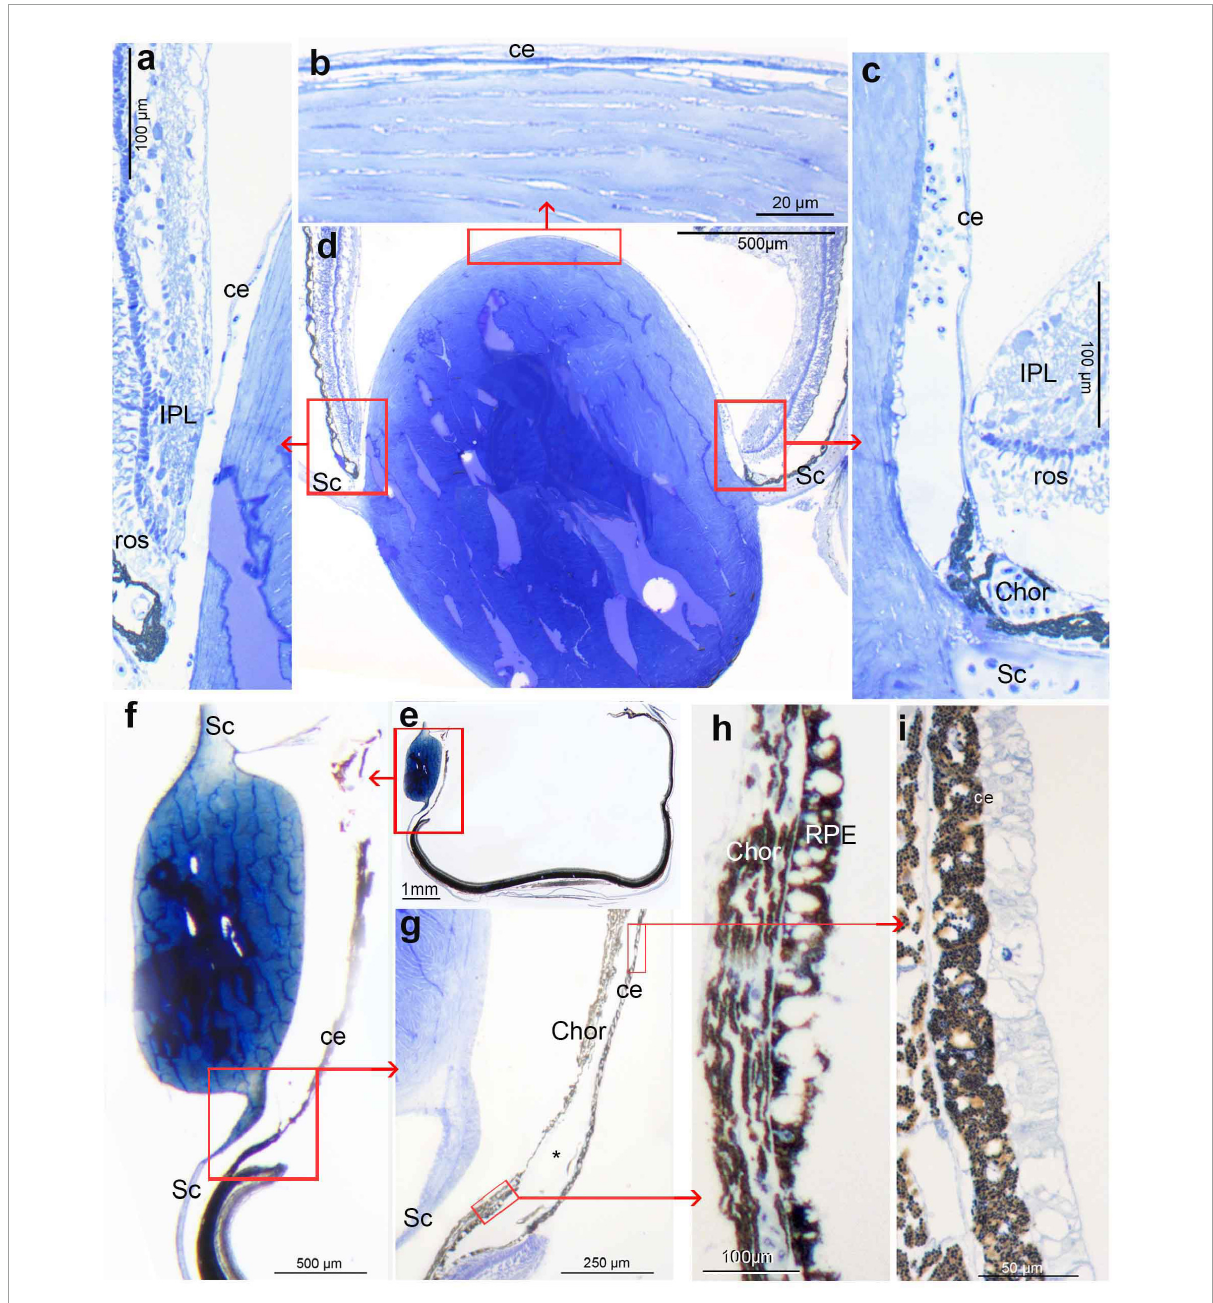
FIGURE6 Bathylychnops exilis : (a–d) semithin sections of the areas around the scleral lens within the ventral diverticulum in the same orientation as indicated in Figure 5 ; (a) rostrolateral retina and scleral lens; (b) high power light micrograph of the dorsal region of the diverticular scleral lens; (c) semithin section of the retina adjacent to the lens mediocaudally; (d) lower power micrograph of the whole lens, the internal surface of which is covered by a thin ciliary epithelial layer derived from the retinal pigment epithelium and neural elements of the adjacent retina. The continuity of the lens and the sclera is evident in panels (c,d) ; Sections (e–i) show areas of the eye adjacent to the corneal projection and are taken from a more caudal plane than those shown above. (e) Thick section of the eye; (f) semithin section of the corneal projection; (g) caudal aspect of the corneal projection with transition to the sclera and choroidal tissue as well as ciliary epithelium covering it on the inner face. *Indicates an artefactual separation of the layers; (h,i) high power micrographs of the choroid and ciliary epithelium internal of the corneal projection, both of which show a high degree of pigmentation suggesting light cannot enter the eye by this route. The ciliary epithelium consists of a continuation of the retinal pigment epithelium and a transparent layer of non-photoreceptive